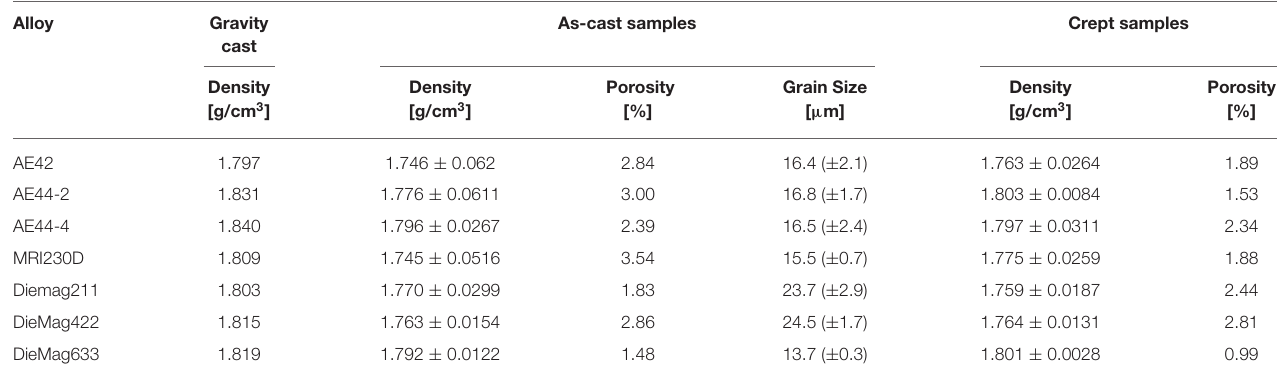
TABLE 2 | Densities of as-cast and crept materials and grain size measurements of as-cast alloys. Alloy